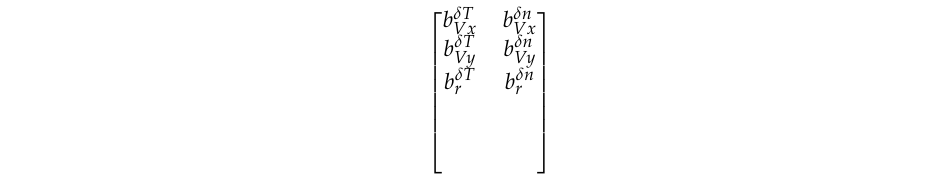
Table 2. Command matrix for longitudinal motion B .